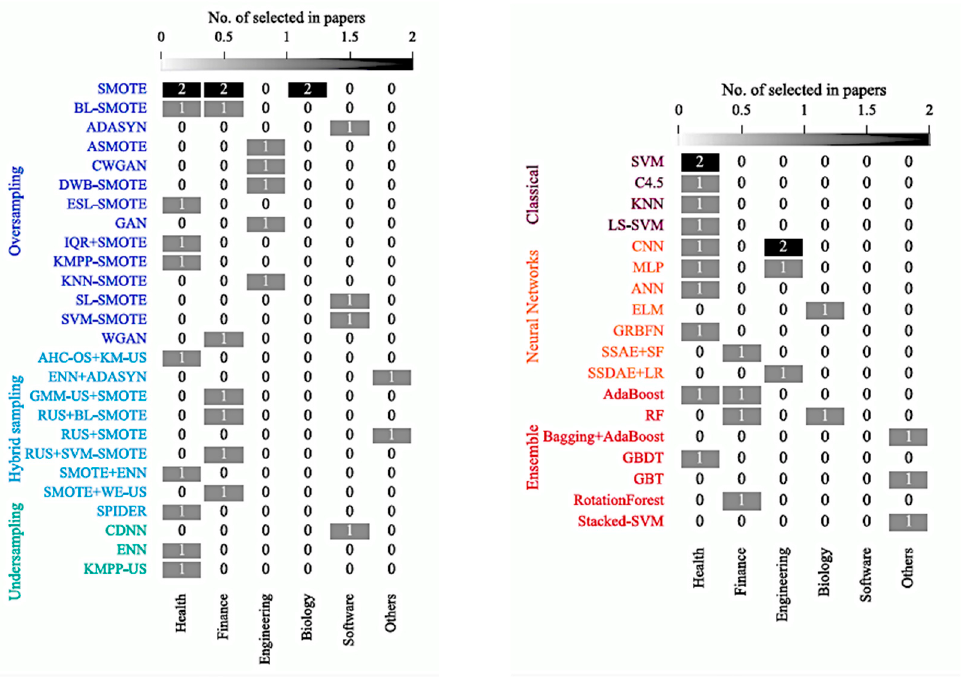
Figure 8. Common resampling techniques and classifiers deployed in previous studies [57].